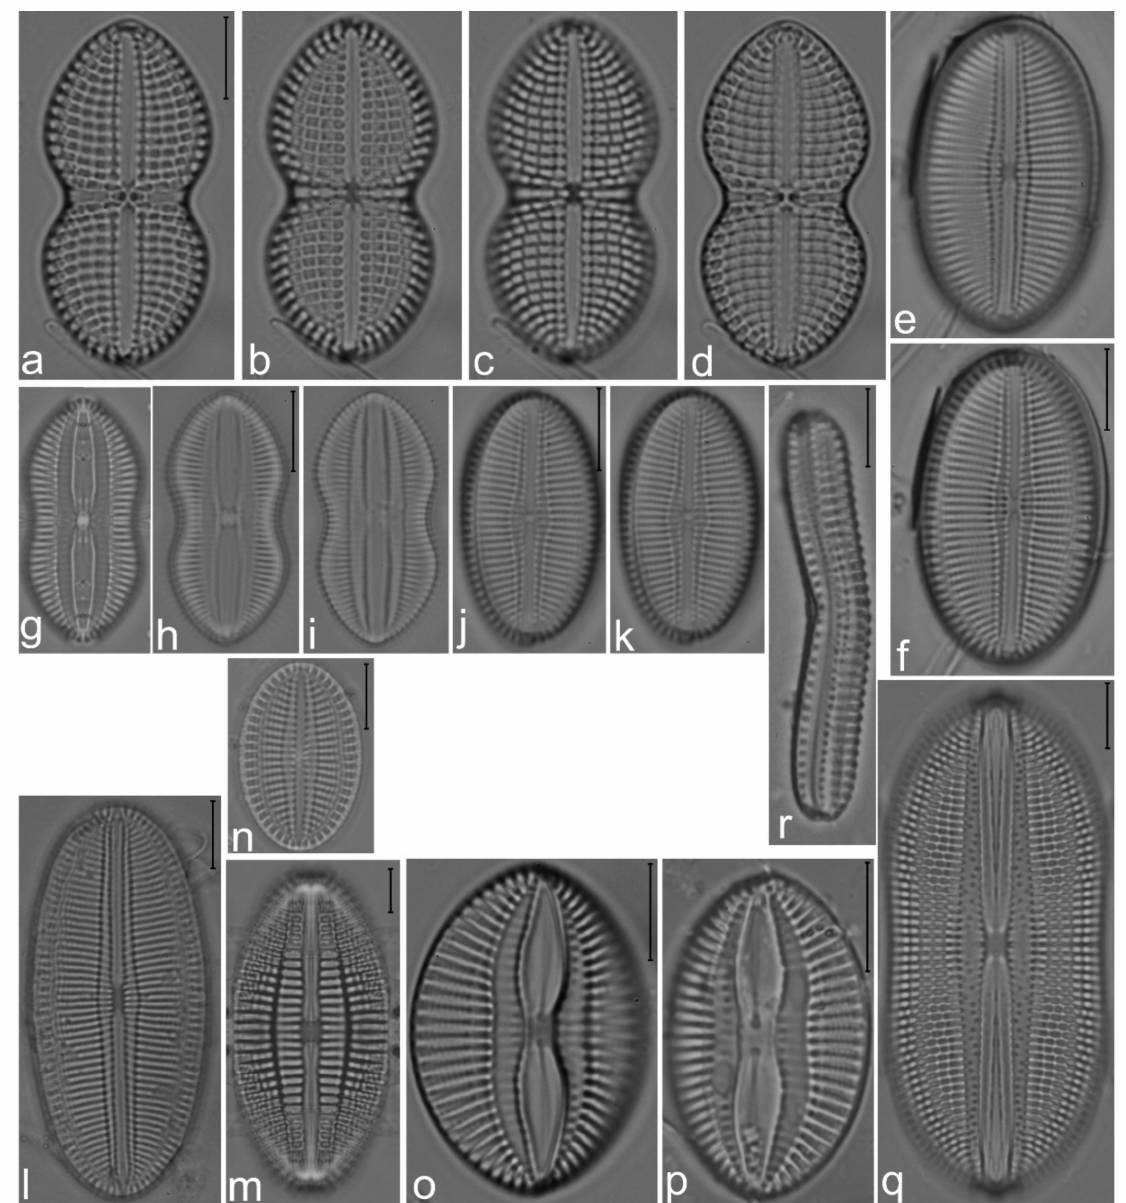
Figure 14. ( a – d ) Diploneis weissflogii ; ( e , f , j , k ) D . parca ; ( g – i ) D . cf. muscaeformis var. constricta ; ( l ) D . littoralis var. clathrata ; ( m ) D . smithii var. smithii ; ( n ) D . vacillans ; ( o , p ) D . suborbicularis ; ( q ) D . cf. didyma ; ( r ) Achnanthes brevipes var. intermedia . Scale bar = 10 µ